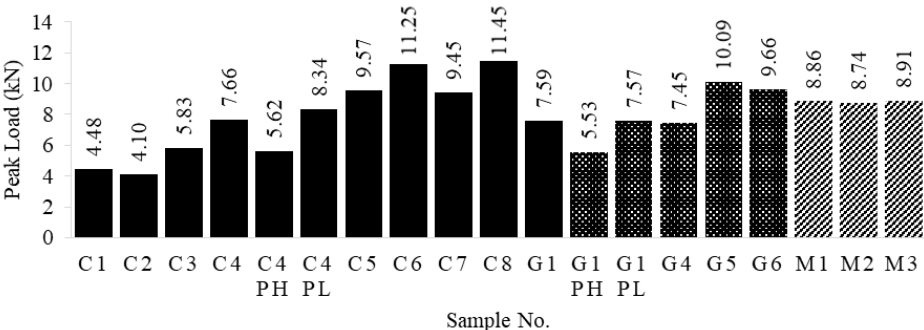
Figure 5. Summary of the measured peak loads for all composite plates.